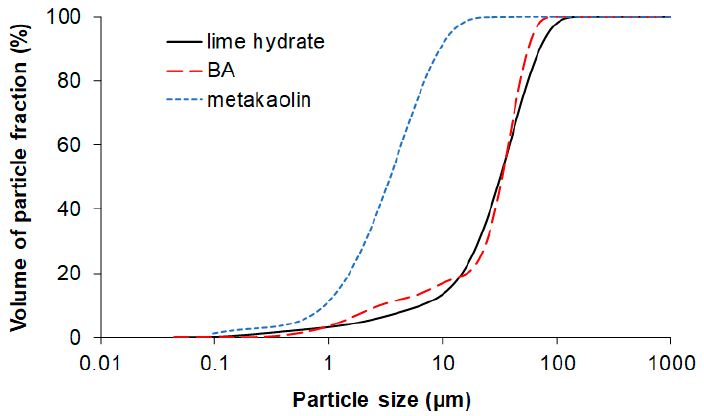
Figure 3. Particle size distribution—distribution curves.